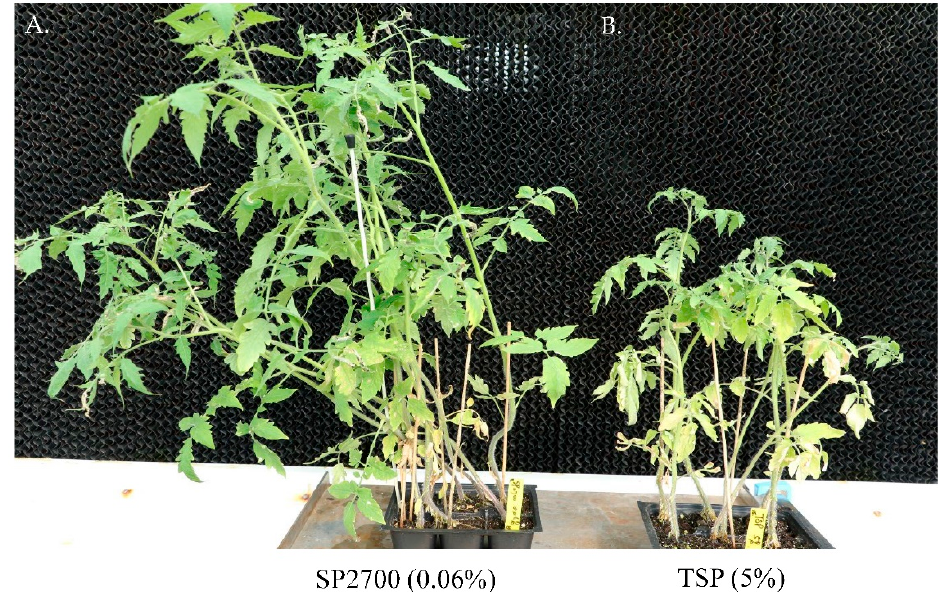
Figure 3. Comparison of plant growth enhancement on tomato ‘Paipai’ plants treated with SP2700 and plant growth suppression on other tomato plants treated by trisodium phosphate (TSP). ( A ) tomato plants treated with SP2700 (0.06%) had enhanced plant growth. ( B ) Tomato plants treated with TSP (5%) had stunted growth at 6 weeks post inoculation using ToBRFV inoculum that was treated with respective disinfectants.